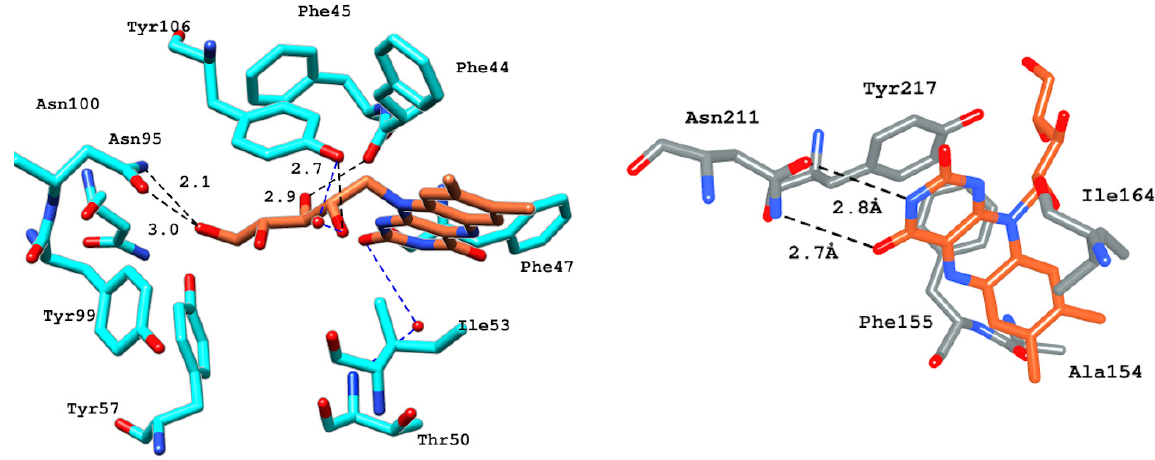
Figure 9. Molecular docking interactions between ZINC2036848 and the binding site of BRD9 (cyan) and BRD7 [17].